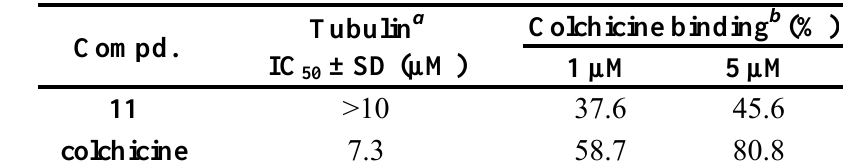
Table 3. Inhibition of tubulin polymerization and colchicine binding by compound 11 and